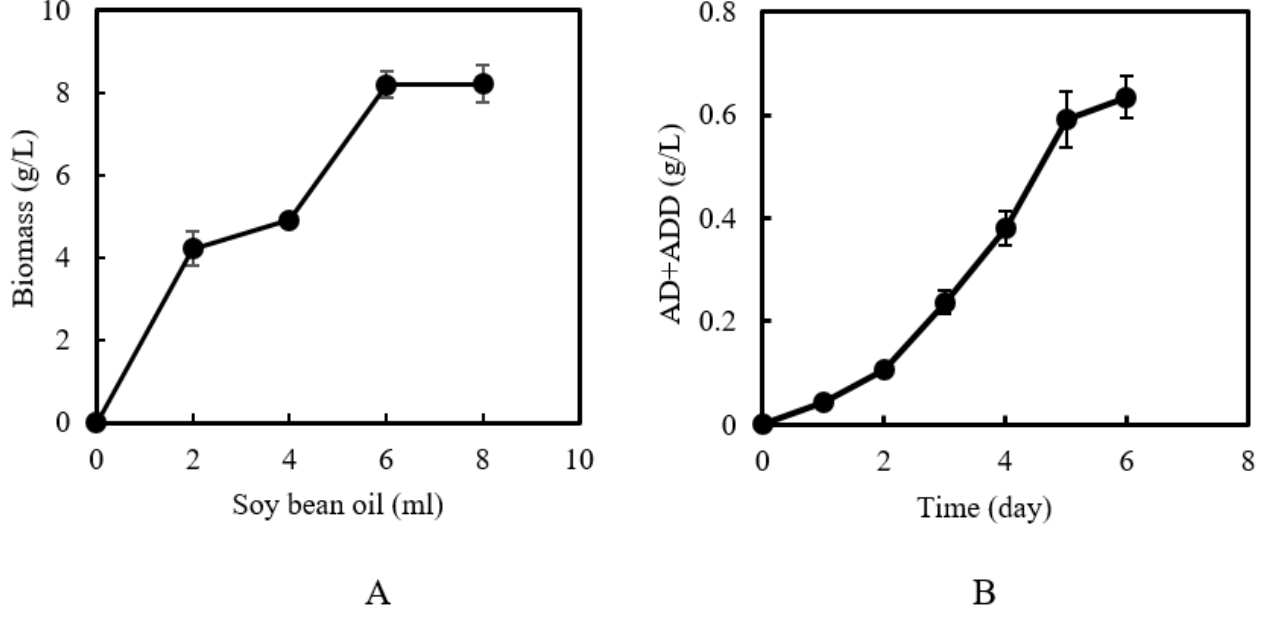
Figure 1. Soybean oil acting as both a substrate for microbial growth and a solvent for solubilized phytosterols: ( A ) Microbial culture with soybean oil as the sole carbon source. The microbial culture was carried out in the aqueous culture medium (40 mL) in the absence of glucose and with various volumes of soybean oil for 6 days. ( B ) Time course of microbial transformation of phytosterols in a water–soybean oil two-phase system. The basic condition was the aqueous culture medium in the absence of glucose (40 mL) and soybean oil (10 mL) with 25 g/L phytosterols.